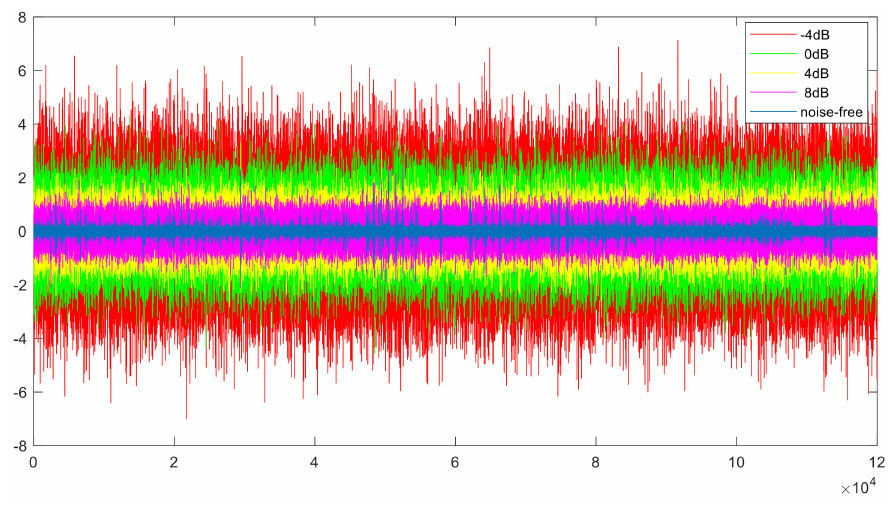
Figure 10. 0.014_ball noise-free and noisy data under 3HP.